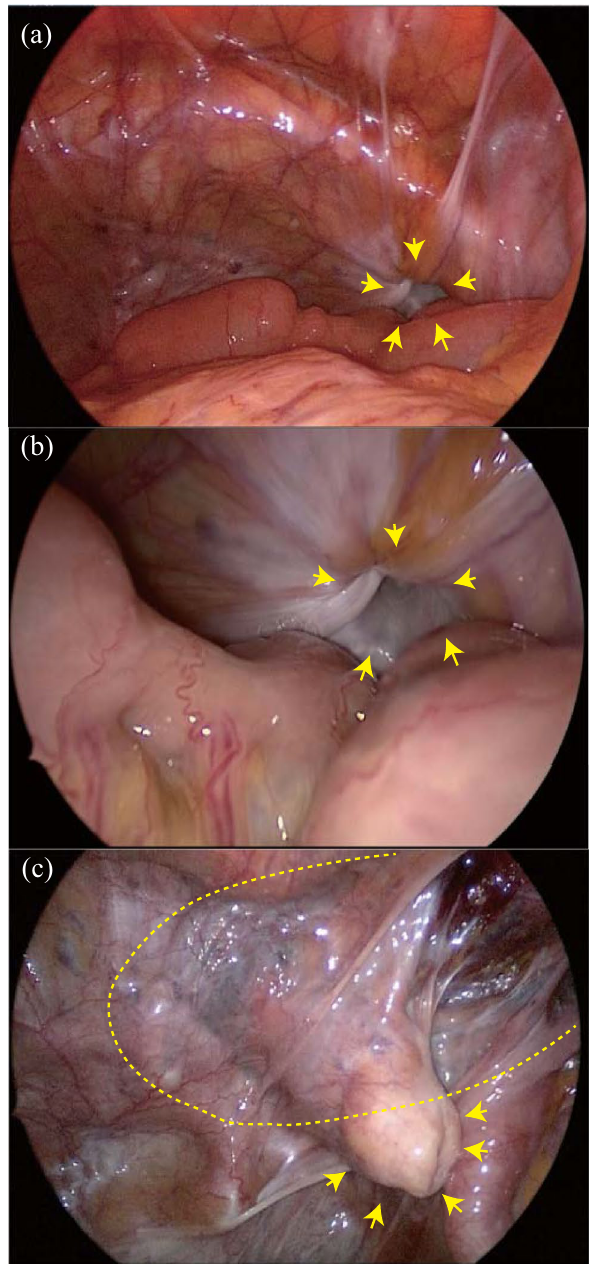
Figure 4. Intraoperative findings. ( a ) Distant and ( b ) close view of obturator hernia (arrows). ( c ) The hernia sac is inverted and not ligated (arrows). BARD ONFLEX modified type L size was placed in the extraperitoneal space (dashed